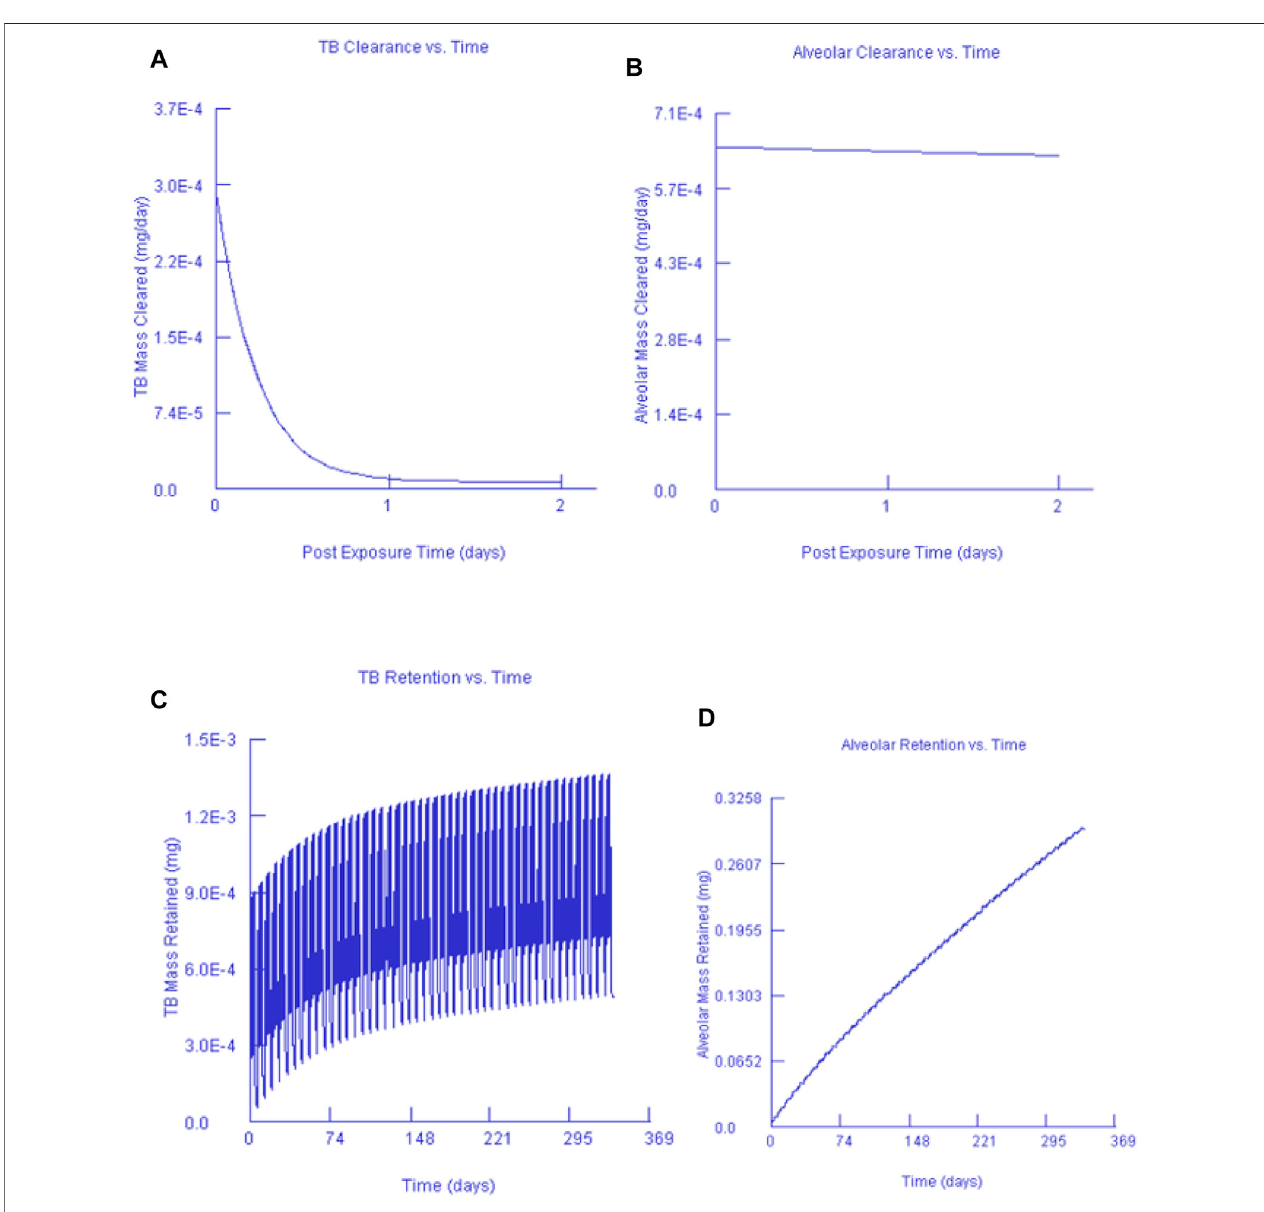
FIGURE 7 | Gold nanoparticles and their corresponding TB clearance (A) and alveolar clearance (B) for simulated post-exposure as well as their TB retention (C) and alveolar retention (D) for simulated continuous exposure.